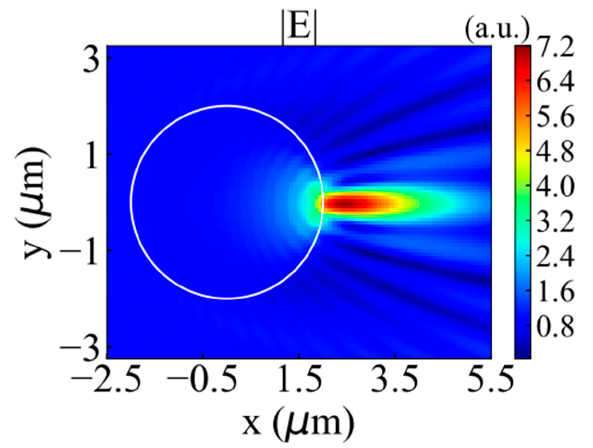
Figure 5. PJ generated by a plane wave with a wavelength of 0.6328 μ m irradiating a GLLs.